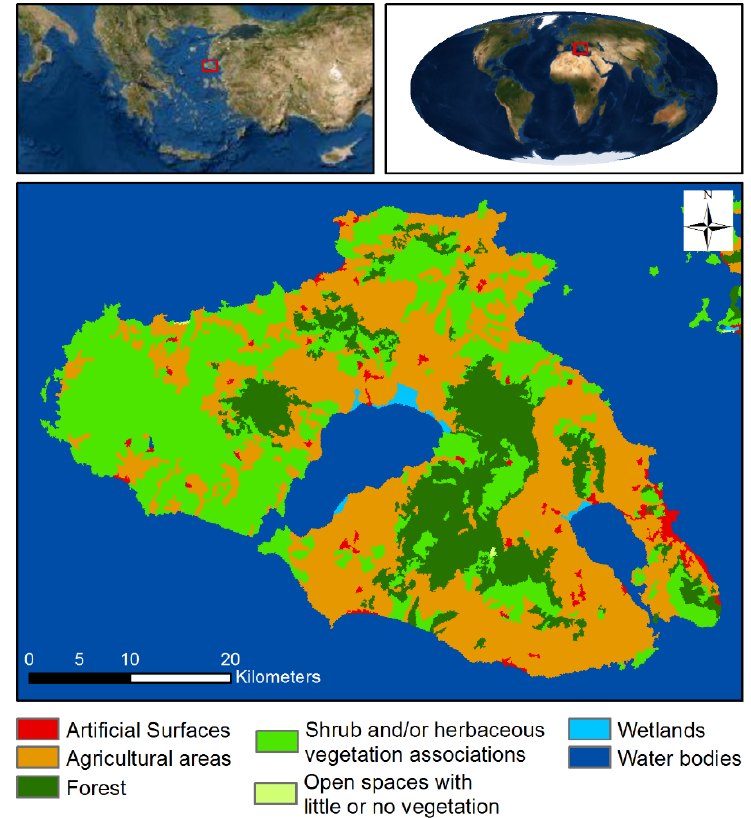
Figure 1. The land cover of Lesvos Island in the northeast Aegean sea according to the corine land cover (CLC) database 2018, version 2020_20u1 (https://land.copernicus.eu/pan-european/corine- land-cover/clc2018 accessed on 10 June 2021).